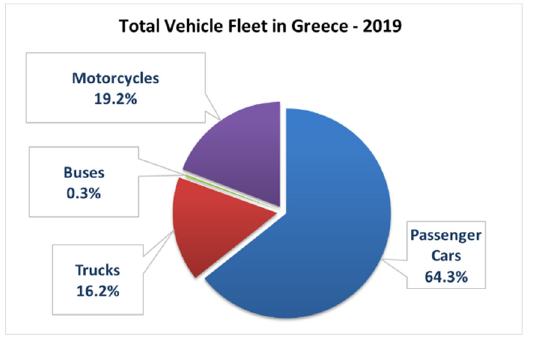
( a ) ( b ) Figure 1. Total vehicle fleet mix for Greece ( a ) and Attica ( b ) for 2019. Figure 1. Total vehicle fleet mix for Greece ( a ) and Attica ( b ) for